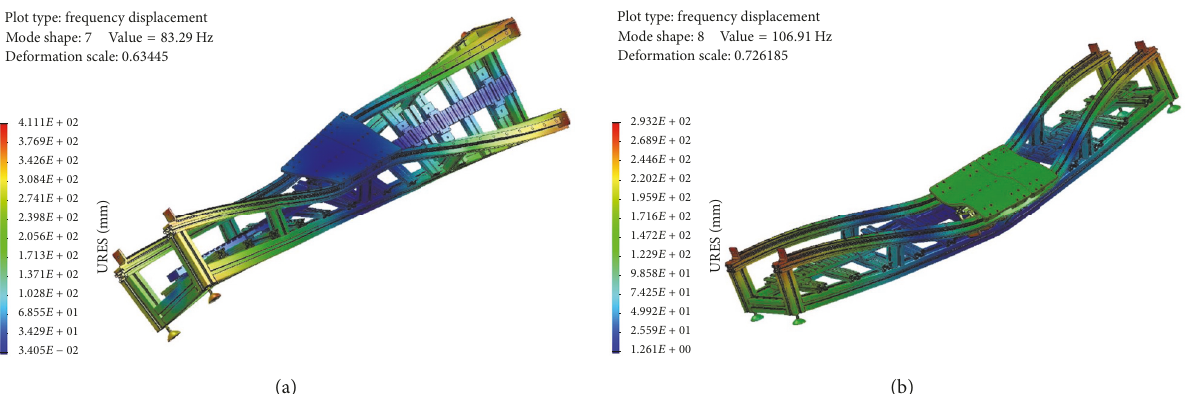
Figure 11: Modal shapes at P3 for: (a) mode 7 ( 𝑓 ≈ 83 Hz, def. scale ≈ 0.634), one node at the central region; (b) and for mode 8 ( 𝑓 ≈ 107Hz, def. scale ≈ 0.602), both ends move vertically.